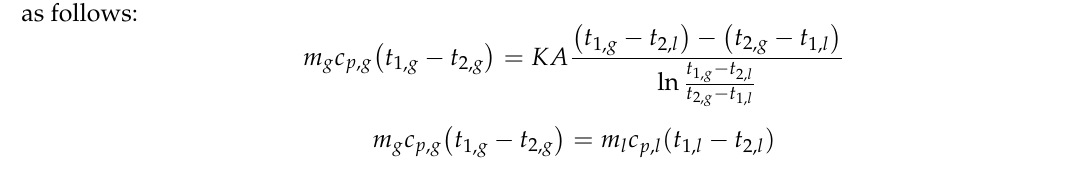
Figure 2. In the heat exchangers, the basic equations of heat transfer and heat balance can be expressed as follows: